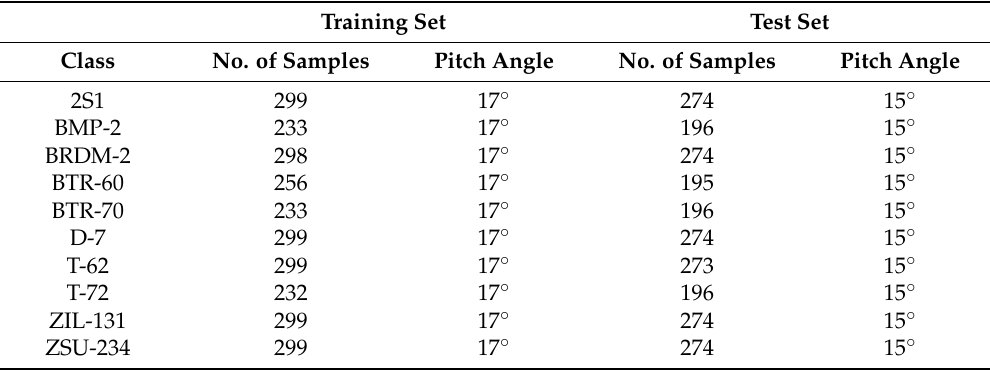
Table 1. Description of training and test sets under SOC.